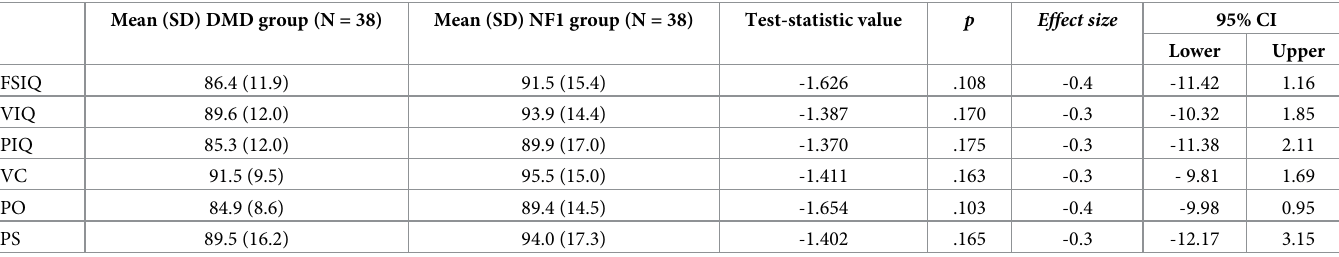
Table 2. Wechsler Intelligence Scale for Children-III outcomes of the DMD and the NF1 group. Mean (SD) DMD group (N = 38)